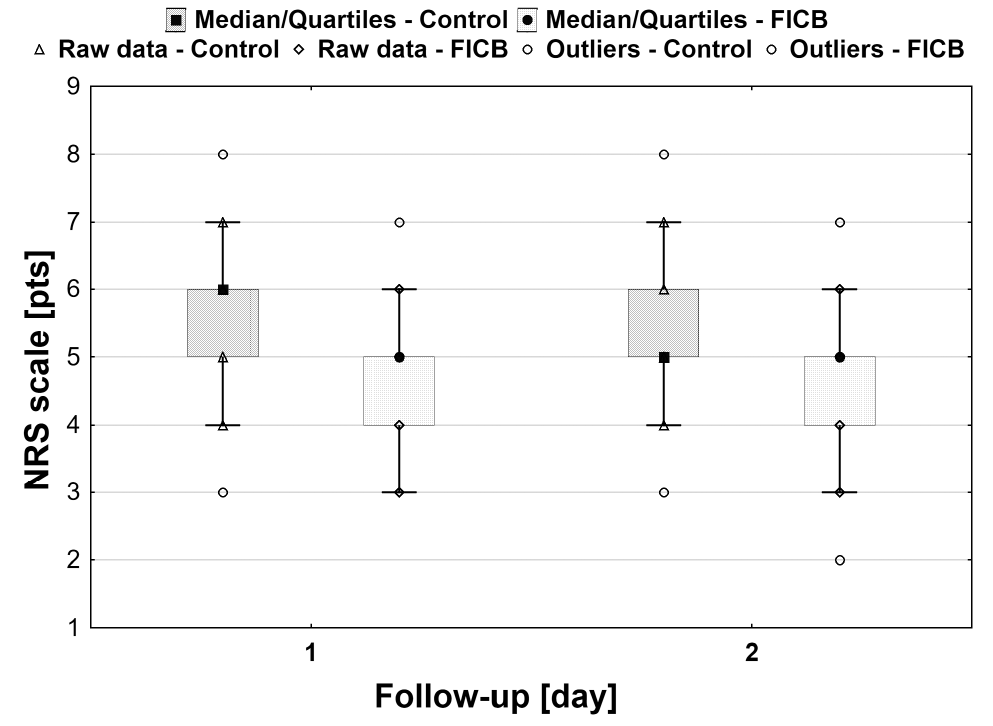
Figure 3. Box-plot of NRS in the control and FICB group during rehabilitation. Pain intensity was significantly lower in the FICB group during rehabilitation on day 1 and 2 postoperatively.